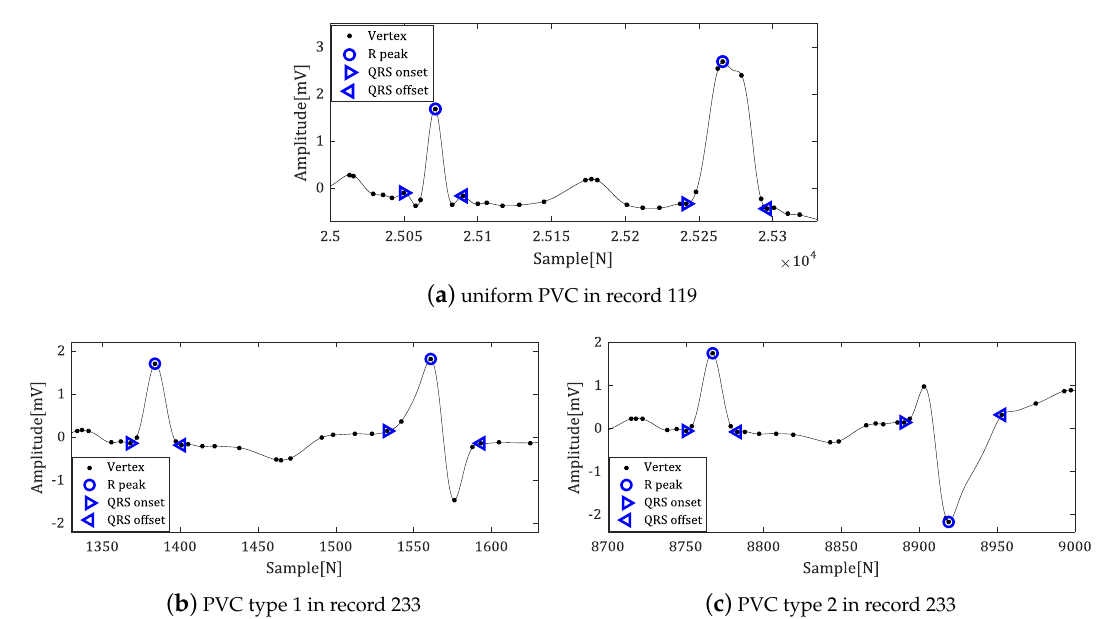
Figure 13. The result of fiducial point detection for arrhythmia